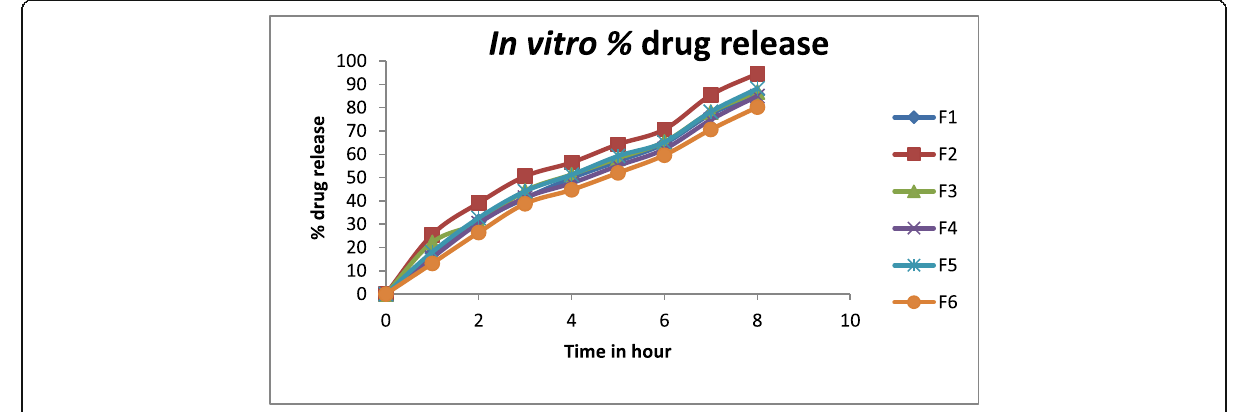
Fig. 5 Graphical representation of in vitro % cumulative drug release